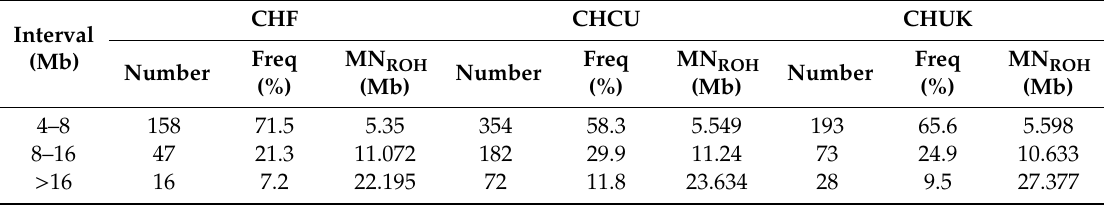
Table 2. Number of runs of homozygosity (ROHs) by breed and interval in Mb. Interval